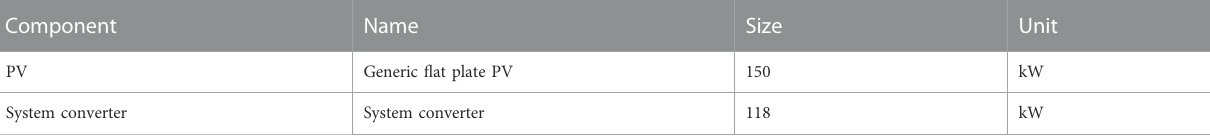
TABLE 2 Components size for the proposed system.